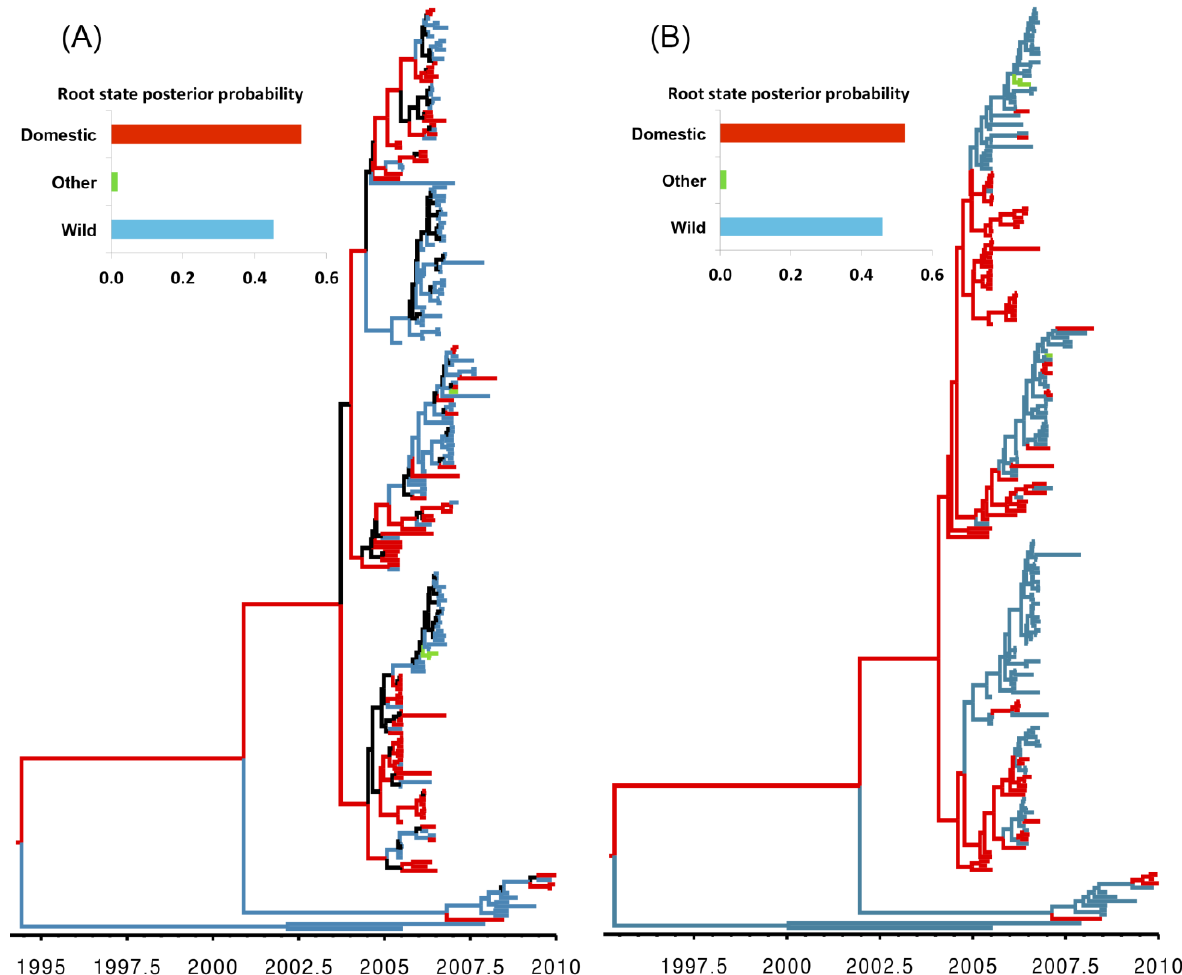
Figure 2. Maximum clade credibility (MCC) trees for H5N1 HPAIV hemagglutinin (HA; A ) and neauraminidase (NA; B ) gene regions, respectively, Branch lengths are rendered proportional to absolute time (see timescales), and branches are colored according to the most probable host type (wild birds, domestic birds, or other). Branches where the host state is uncertain (where the posterior probability of any hosts < 0.5) are colored black. The posterior probabilities for the ancestral host states are shown in the upper left panel for each tree.